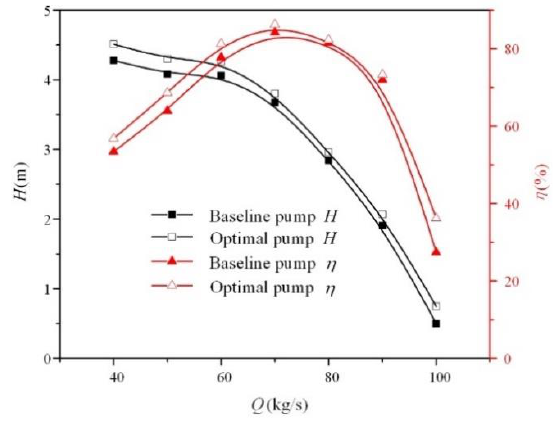
Figure 9. Performance of baseline pump and optimal pump.